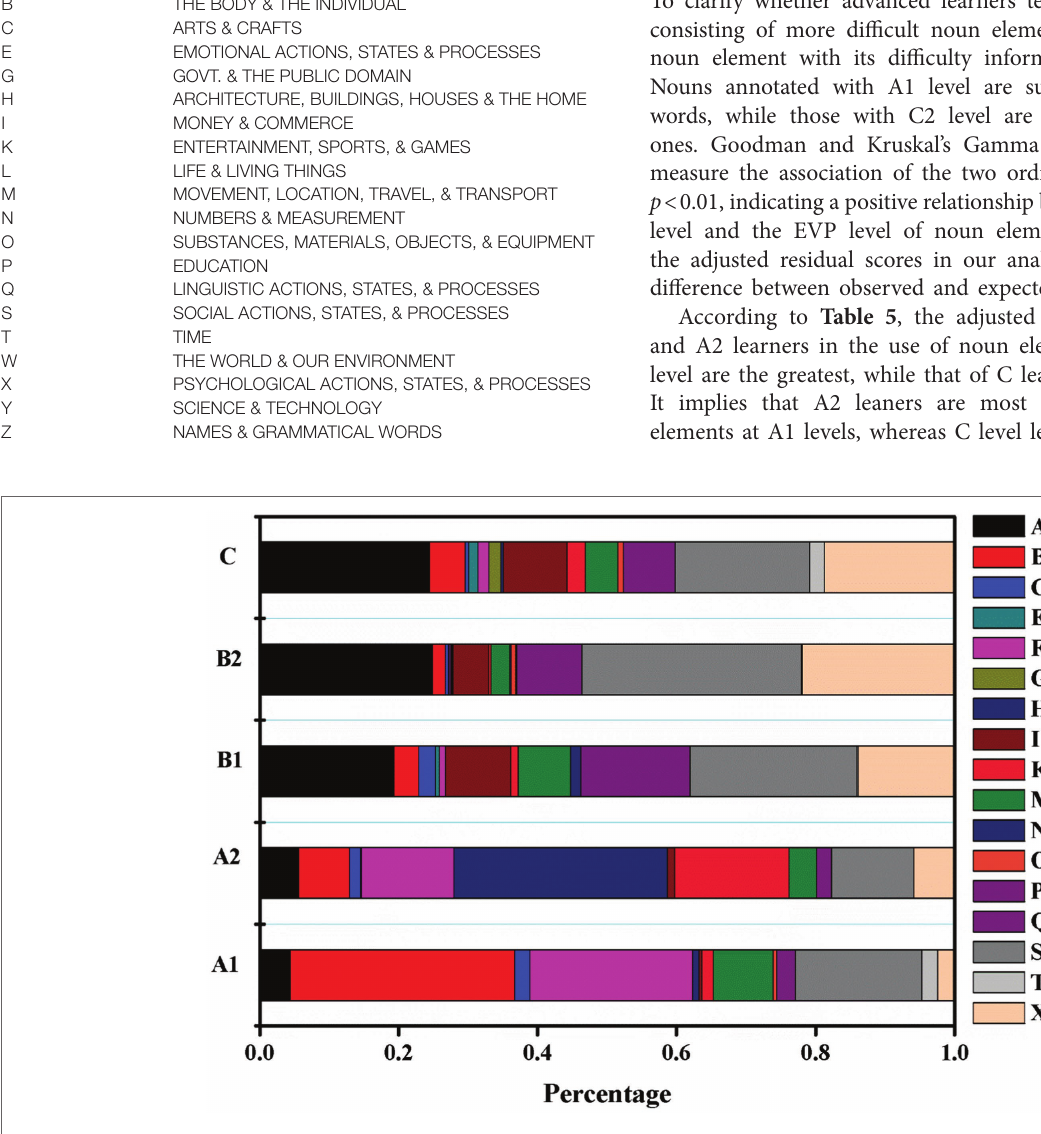
FIGURE 1 | Percentage of nouns in each semantic field across CEFR level.